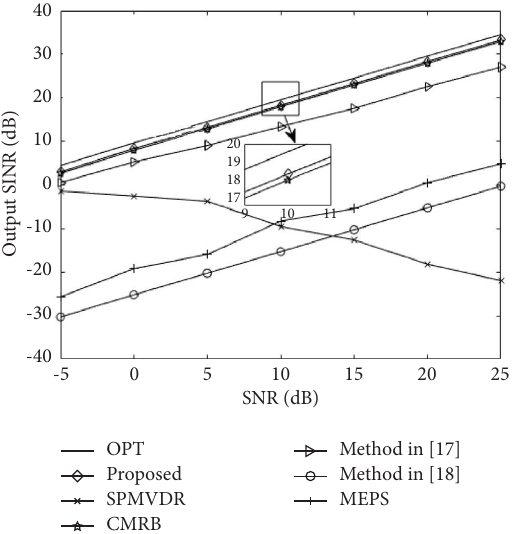
Figure 6: Output SINR versus SNR with the steering vector random